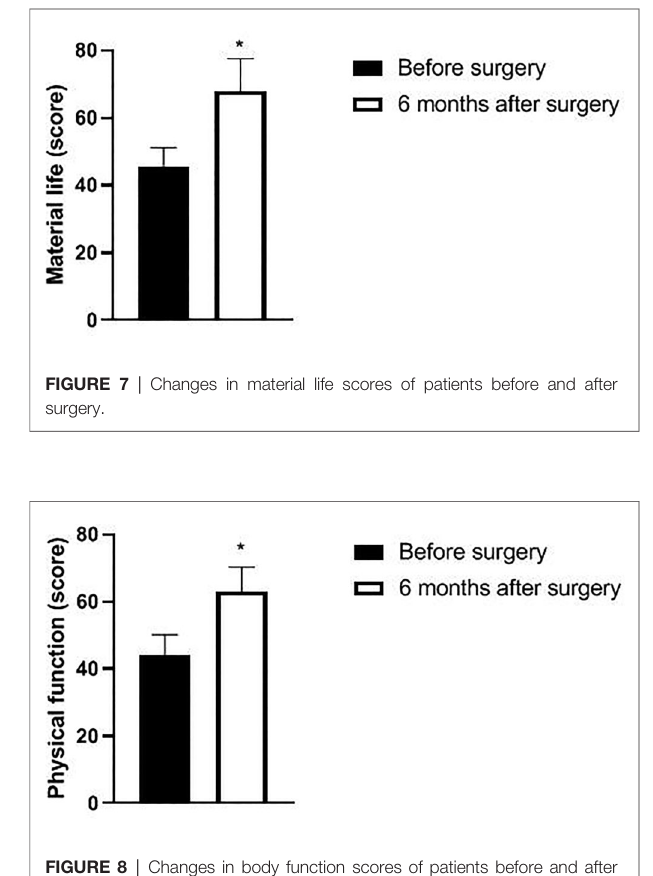
FIGURE 8 | Changes in body function scores of patients before and after surgery. Note: compared with before surgery, * p <0.05. Note: compared with before operation, * p <0.05; compared with one month after surgery, # p <0.05.